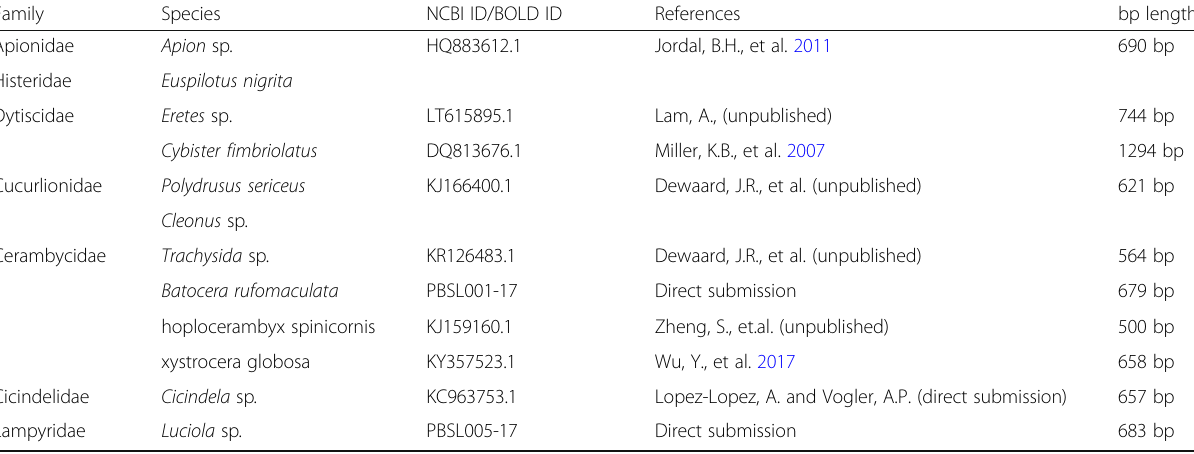
Table 3 Families of Coleoptera with their species submitted to NCBI along with its extension numbers by different authors used in the present report (Continued)